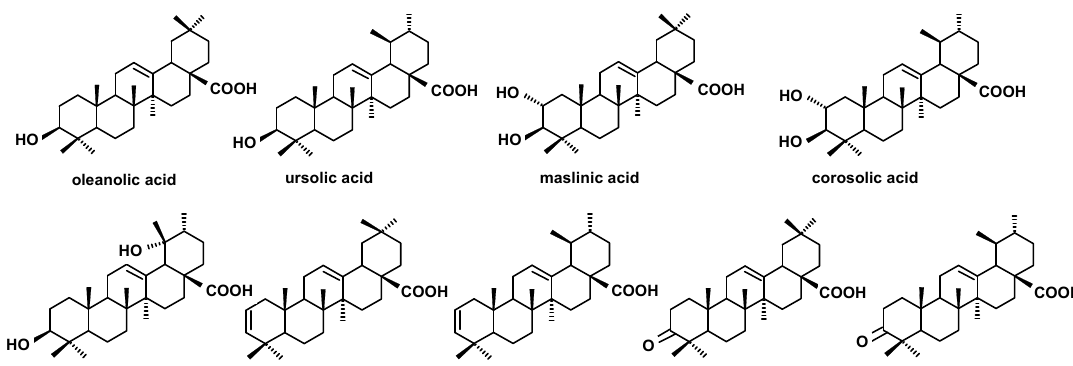
Figure 6. The structures of triterpenoid acids identified in cuticular waxes of fruit analyzed in this study.